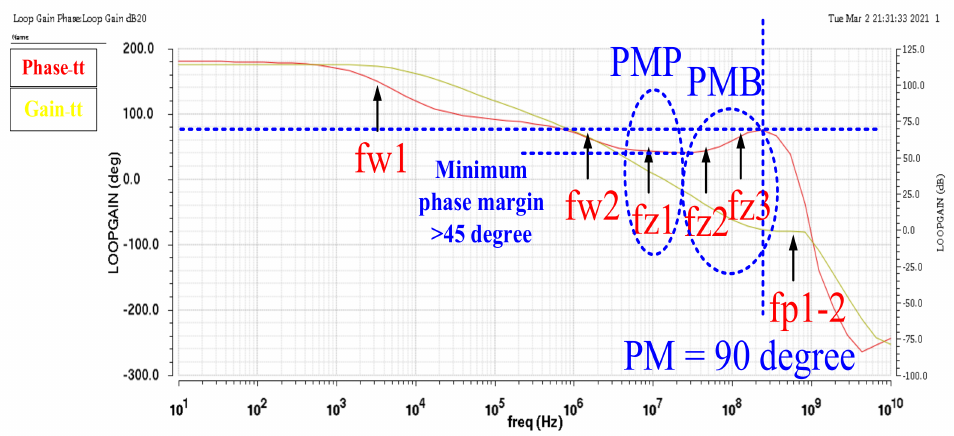
Figure 9. The simulated bode diagrams of the DLAFC